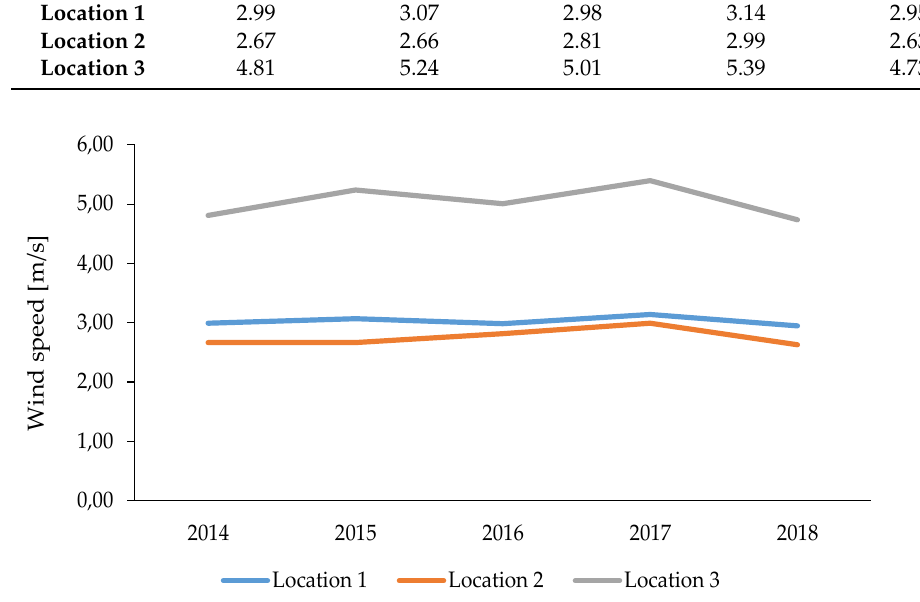
Figure 10. Average wind speeds at the tested locations in 2014–2018.